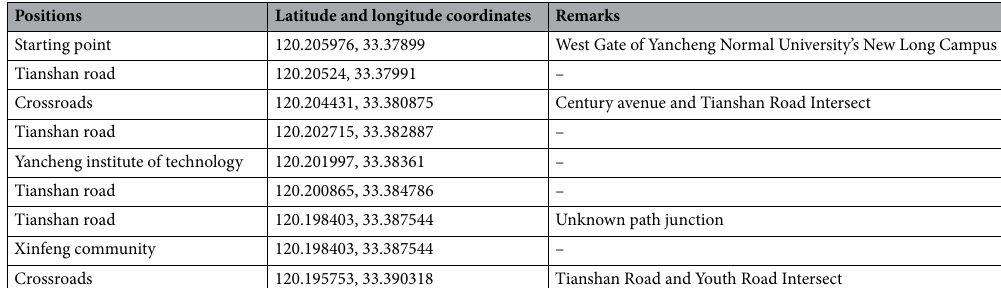
Table 8. The table mainly includes location, longitude and latitude coordinates and remarks. The location is divided into starting point and Tianshan Road. The longitude and latitude coordinates are consistent with the location.